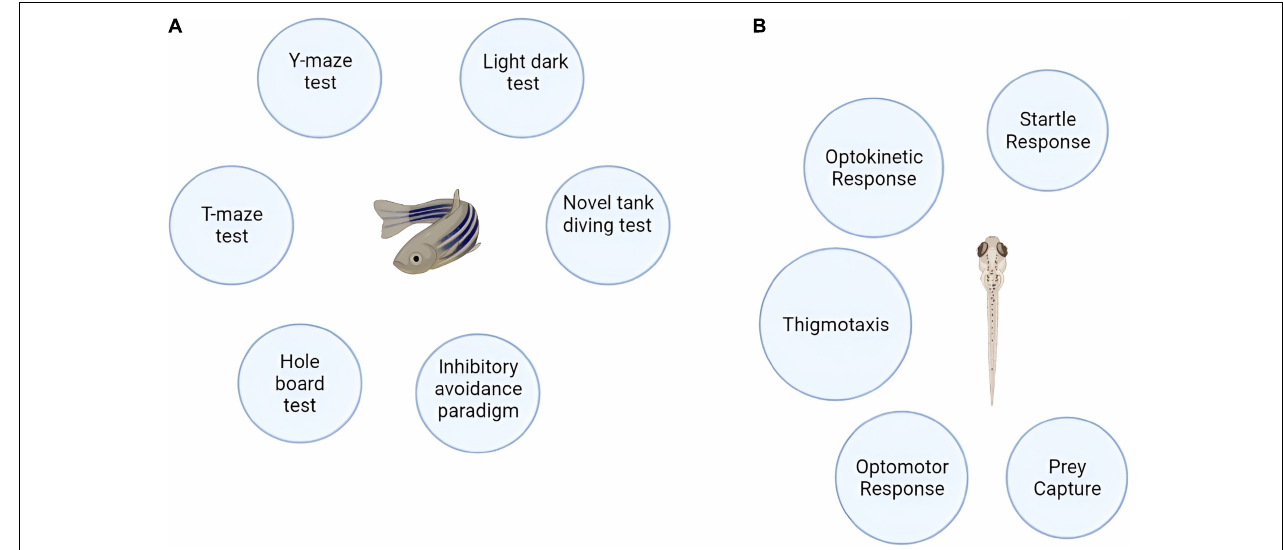
FIGURE 3 | (A) Behavioral models of adult zebrafish. (B) Behavioral models of zebrafish